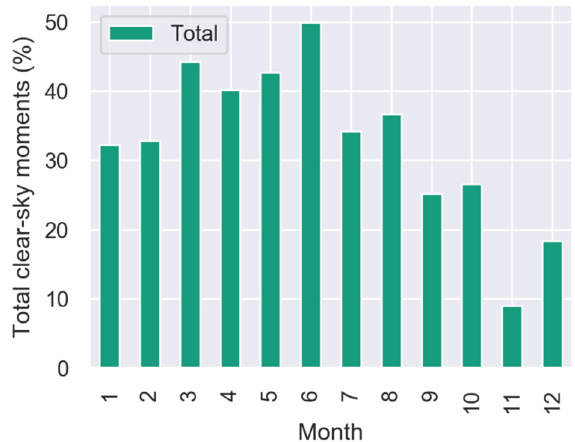
Figure 5. Monthly distribution of clear-sky moments from a PV system located in south-west Germany in the year 2017.